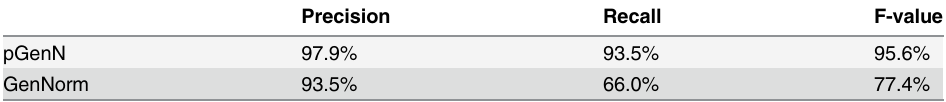
Table 9. Performance of pGenN & GenNorm on use case data